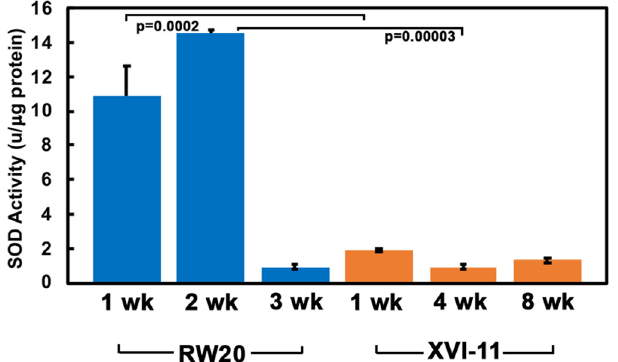
Figure 5. Comparison of SOD activity levels in short-lived RW20 and long-lived XVI-11. SOD activity was determined using a colorimetric assay kit (Sigma). The kit was first standardized for use with Daphnia samples. All reactions were performed in a 96 well plate and the activity was read on a BioTek Plate reader at a wavelength of 450 nm using the Gen5 software that was included as part of the Bio-Tek plate reader. Note that commercially available SOD was used in the assay to develop a standard curve for SOD activity. Blue bars: SOD activity at indicated ages for short-lived RW20 and orange bars: SOD activity at indicated ages for long-lived XVI-11. Error bars indicate the standard error of the mean from 4 experiments. Student T-tests were performed and the p values are as